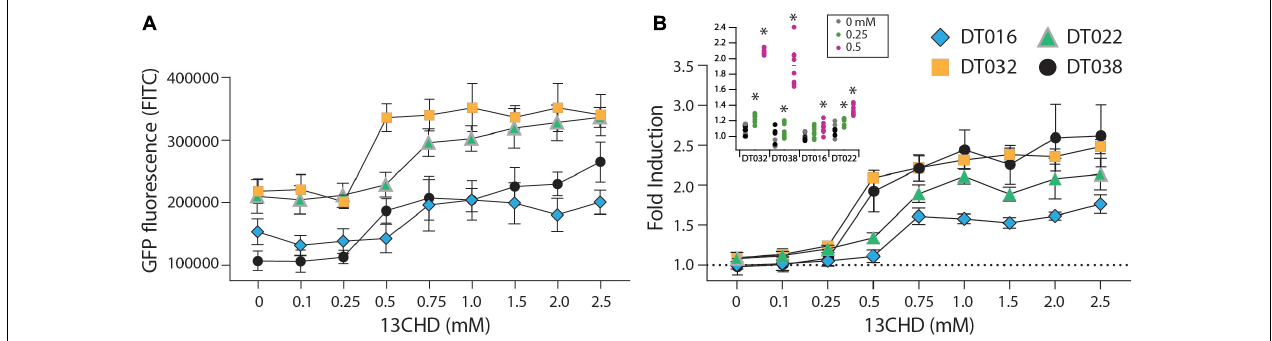
FIGURE 1 | GFPmut2 fluorescence of Escherichia coli BW25113 (cid:49) rbsB expressing DT016 (blue diamonds), DT022 (light green triangles), DT032 (ochre squares), or DT038 (black circles) in presence of different 13CHD concentrations. (A) Average GFPmut2 fluorescence in flow cytometry after 2 h incubation with a range of 13CHD concentrations. (B) As (A) , but as fold induction compared to uninduced conditions. Each point shows the mean of eight biological replicates (each from a measurement of 100,000 cells). Error-bars indicate calculated SD (not visible when inside the symbol). Dashed line represents the non-induced level. Inset in (B) Asterisks point to the lowest tested 13CHD concentrations giving a statistically significantly different fluorescent signal compared to the blank control (incubated in absence of any 13CHD, p < 0.05, two-sided t -test, n = 8